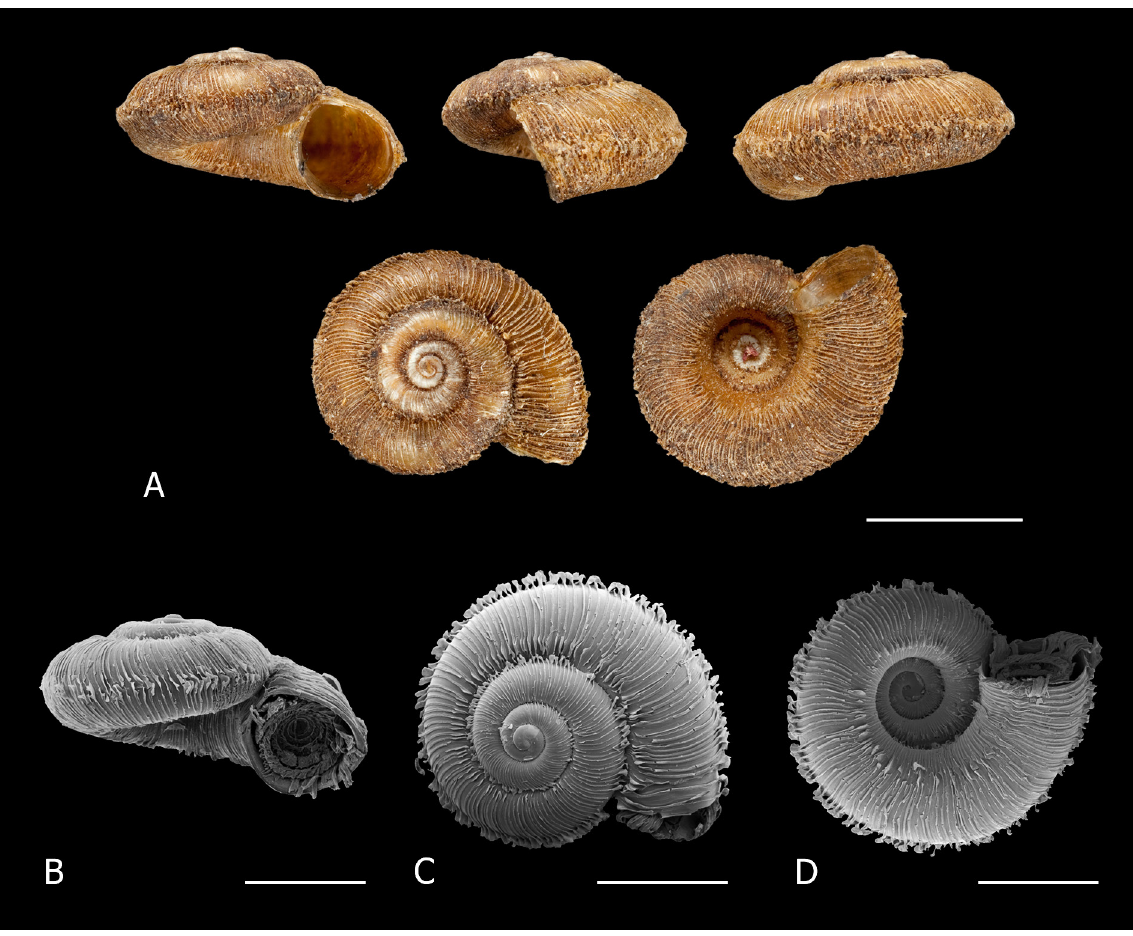
Fig. 20. Chondrocyclus bathrolophodes Connolly, 1929. A . Holotype (NHMUK 1928.3.16.4). B–D . ELM W3616. B . Aperture view. C . Dorsal view. D . Ventral view. Scale bars: A = 3 mm; B–D = 2